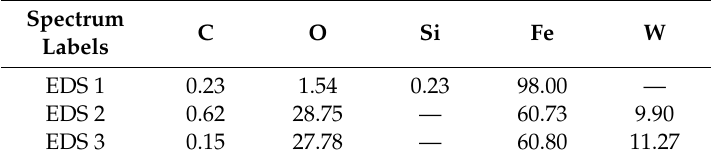
Figure 21. SEM image of wear of the 80 W power group at 2.4 mm / s at the load of 1100 g: ( a ) wear scar morphology; ( b ) enlarged view of micro-textured wear; ( c ) enlarged view of; ( b ) texture wear and tear image. Table 9. Figure 20c EDS